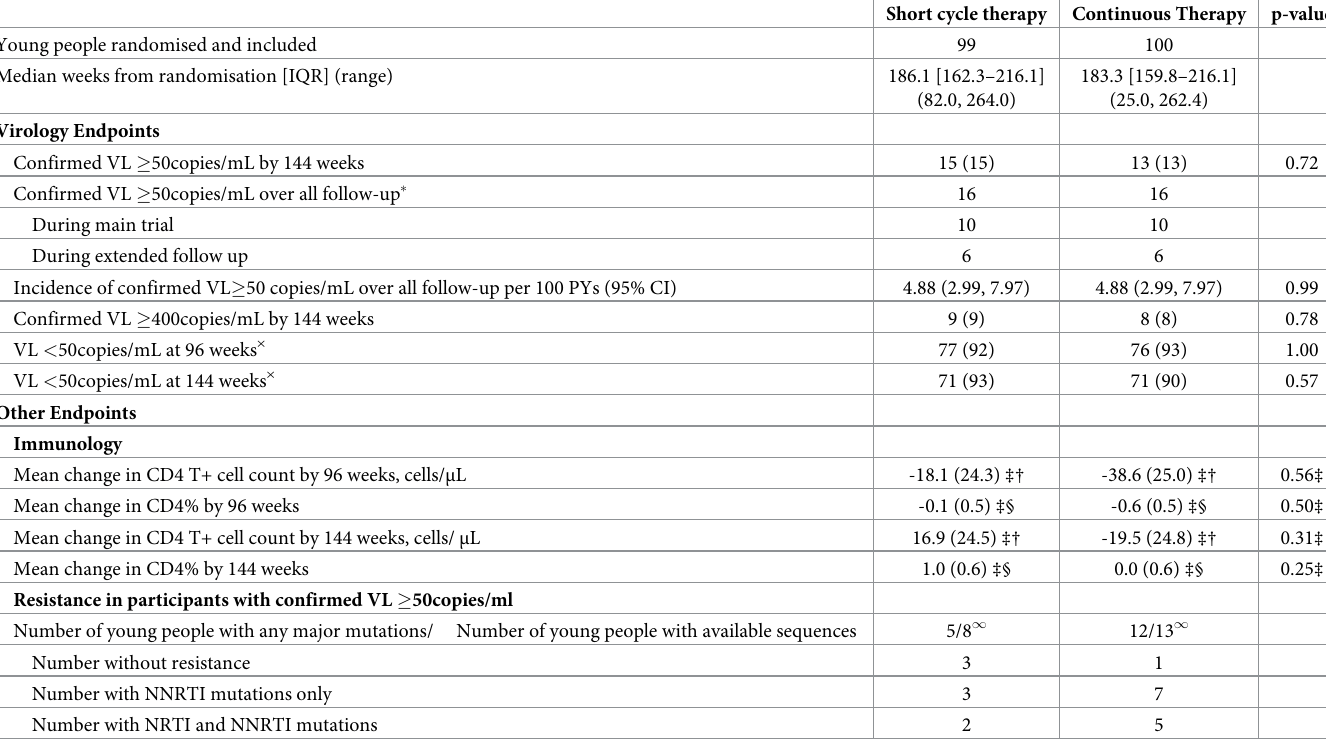
Table 2. Virology, immunology and secondary endpoints over all